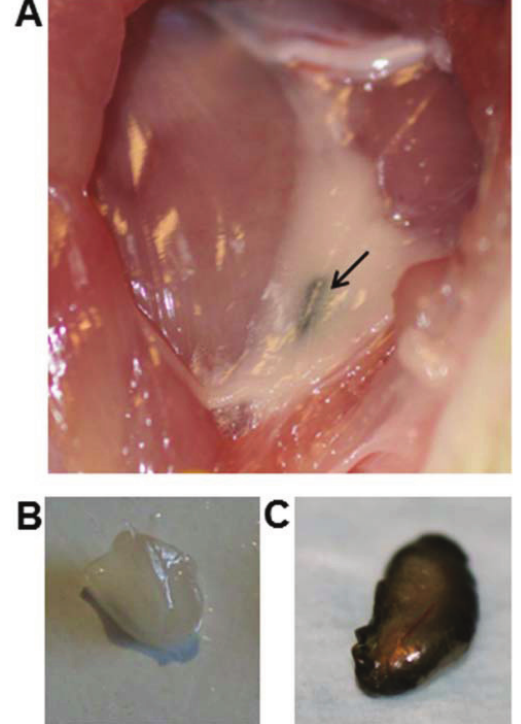
Figure 5. Intraoperative identification of the SLN using 99m Tc-AF-SPIONs. ( a ) Similar to the clinical procedure using blue dye, 99m Tc-AF-SPIONs stain the SLN green, which makes it easy to be identified during surgery. ( b ) The reference node from the collateral side of the animal. ( c ) The resected